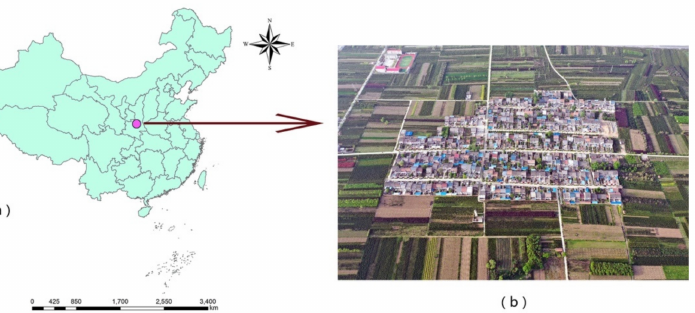
Figure 1. The location of the study area: ( a ) Guanzhong plain in, Shaanxi, China. ( b ) Image of Caijia